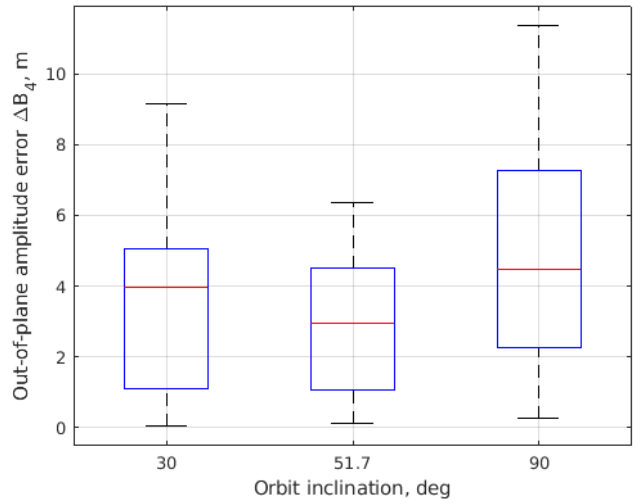
B after convergence. Figure 23. Mean error in B 4 after 4